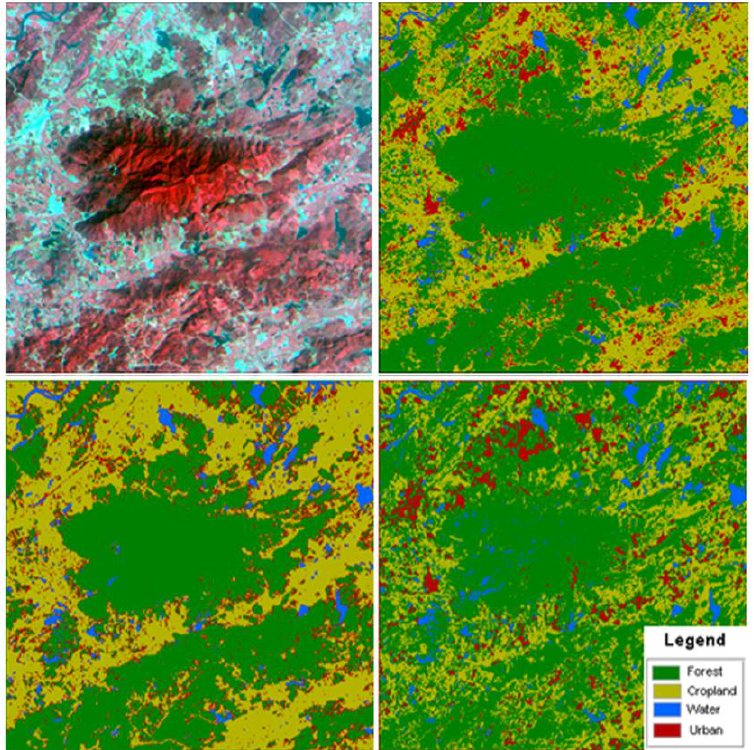
Figure 13. The subset image for area A in false-color (( upper left ) R: band 4, G: band 3, B: band 2) and classified image using ( upper right ) spectral shape-based method, ( lower left ) SVM method and ( lower right ) MD method.